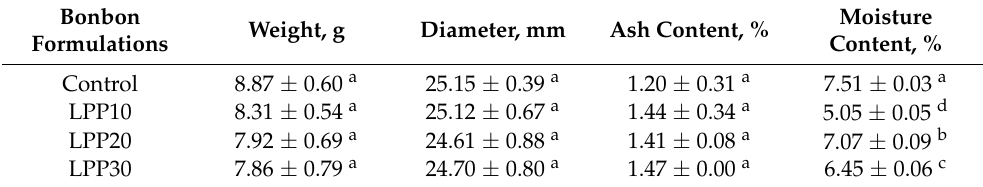
Table 2. Weight (g), size (mm), ash (%), and moisture (%) content of bonbons.